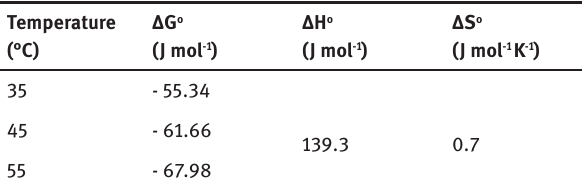
Table 4: Thermodynamic parameters of the adsorption of the reactive red RB dye in cellulose, pH